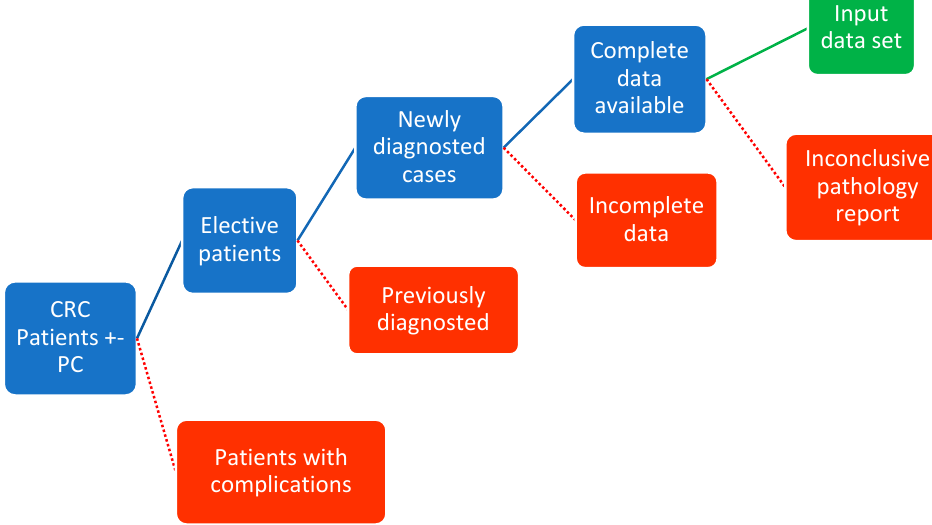
Figure 1. Flowchart of patient inclusion and exclusion algorithm.